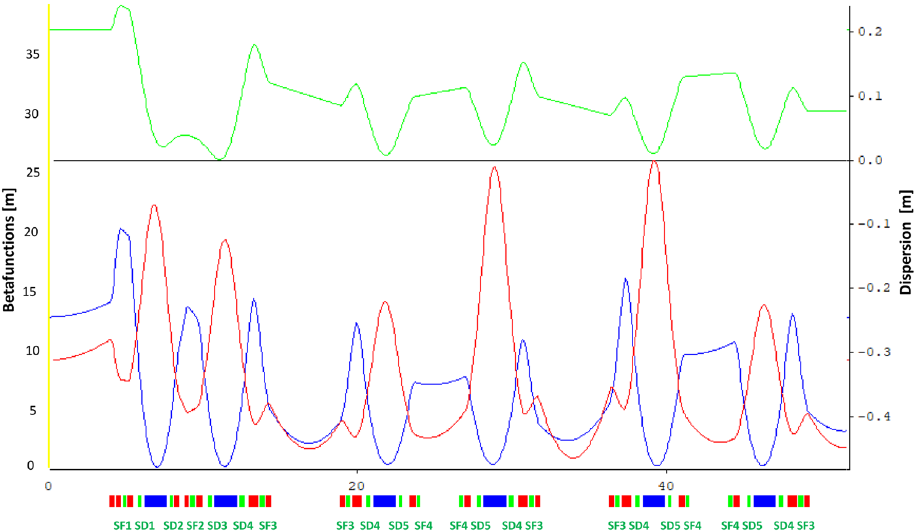
Figure 2. Optical functions of a half super period of the ALBA-like lattice. The functions β x ( s ) and β y ( s ) are marked in blue and red, respectively; and in green, the dispersion function η( s ) . The lower part shows the distribution of dipoles (blue), quadrupoles (red) and sextupoles (green) of the three DBA-cells in a half super period. The lower green text line shows the assignment of the different sextupoles. The other half of the superperiod is symmetric about the vertical axis. The ring is composed of four